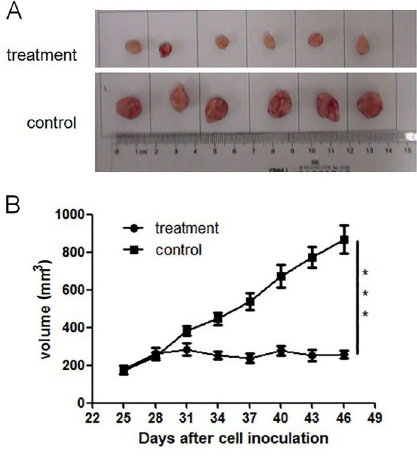
Figure 4. Inhibitive effects of ethanol extracts of Antrodia cinnamomea (EEA) on tumorigenesis in vivo . A and B , Nude BALB/c mice were inoculated with SAS cells and treated with EEA when tumors were palpable. Tumor growth was signi fi cantly inhibited by EEA administration. Data are reported as means ± SD. ***P o 0.001 (ANOVA).